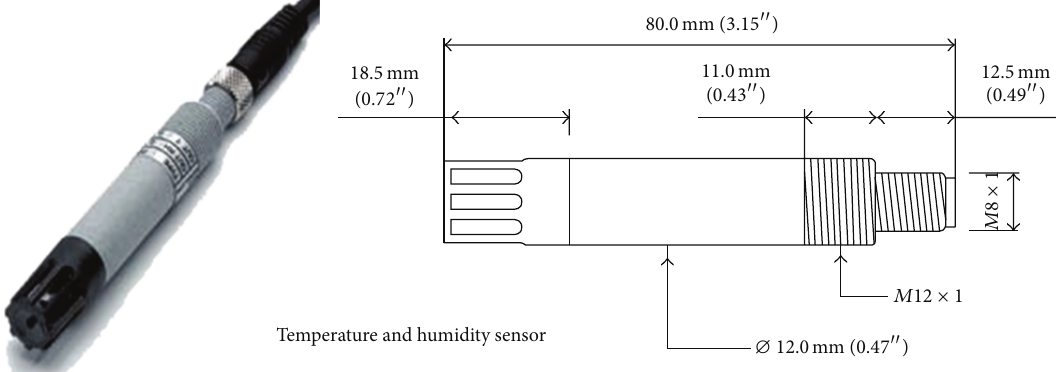
Figure 1: Schematic diagram of installation of the